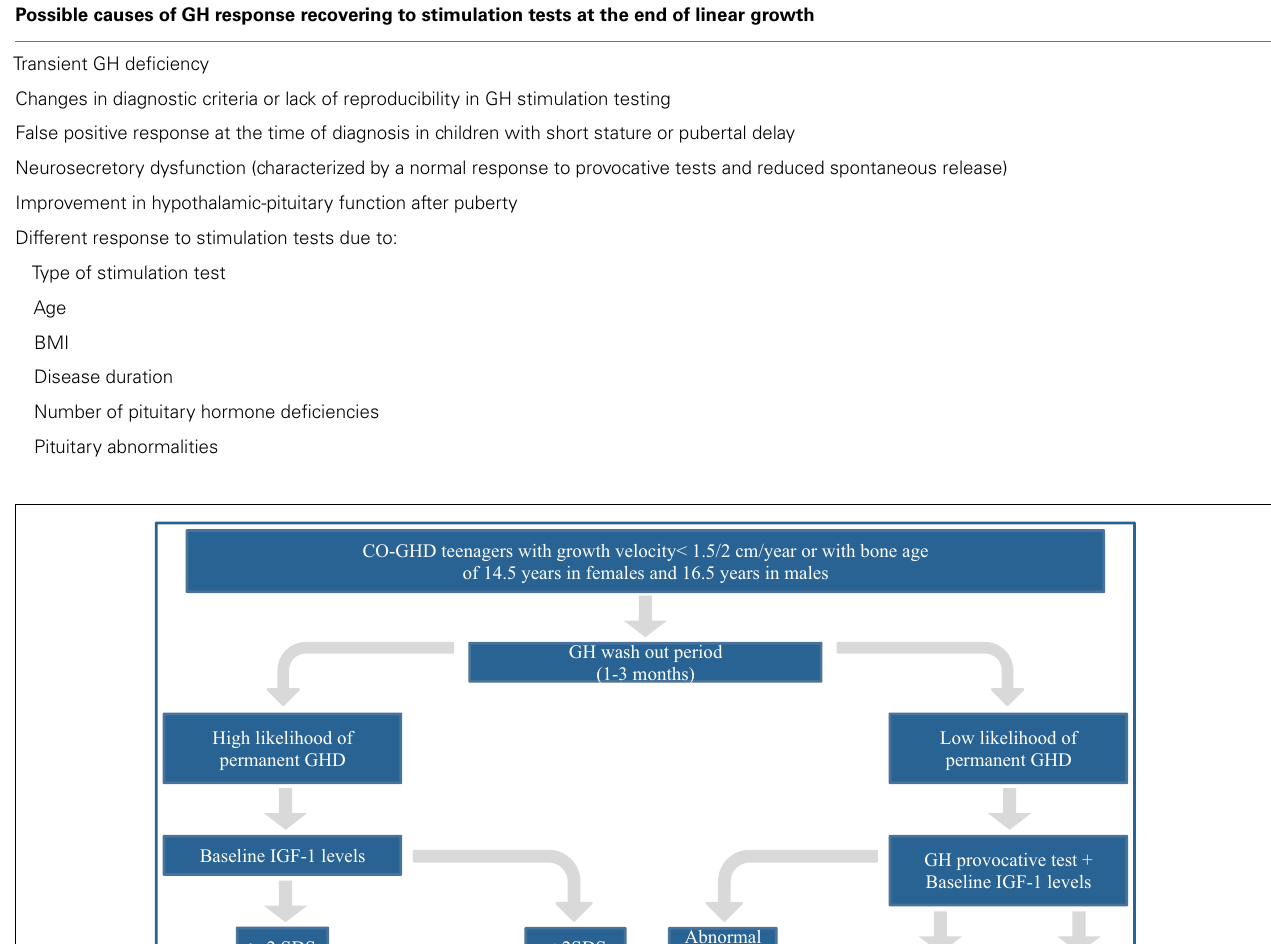
Table 3 | Possible causes of recovering a normal GH response to stimulation tests.